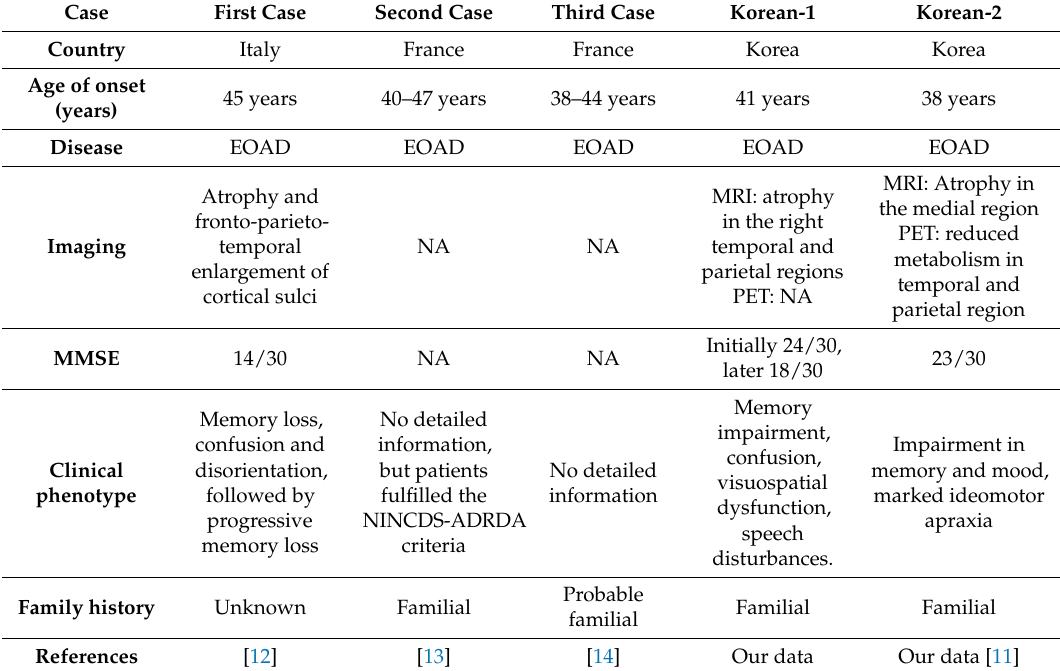
Table 1. Comparison of EOAD cases, associated with PSEN1 T116I